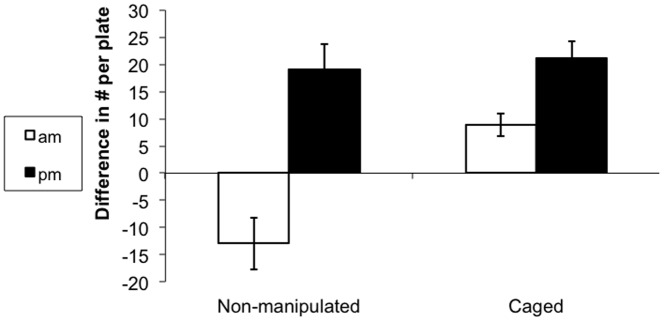
The abundance of Ulva sp. at areas exposed to grazing decreases only at morning hours.Average change (±SE) in the abundance of Ulva sp. (number of “spots” per 10×10 cm plate) of Ulva sp. on non-manipulated and caged plates between 7:00 to 12:00 (am, open bars) and between 12:00 to 17:00 (pm, full bars).